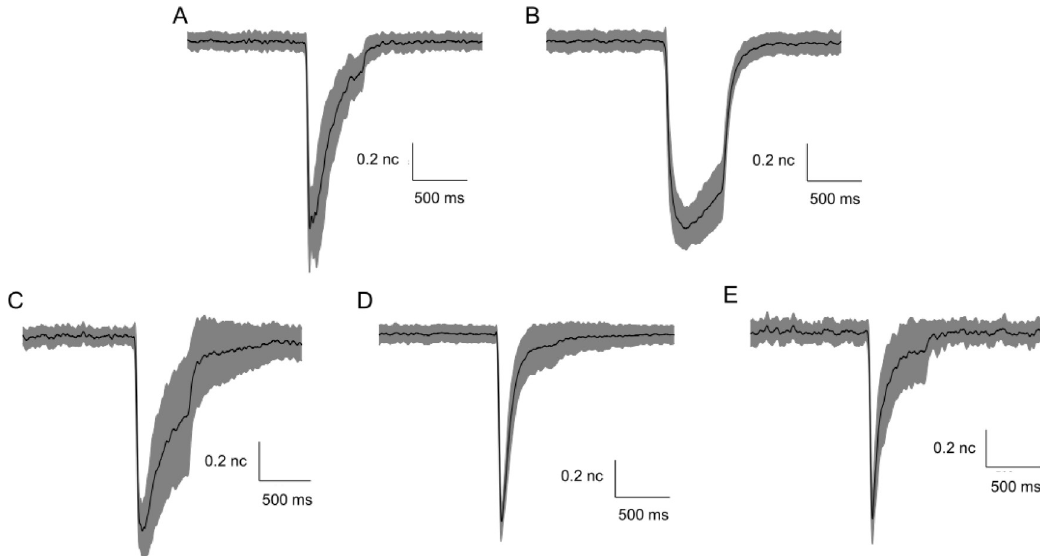
Fig 6. Normalized mean whole-cell currents from cotransfected E2117A and E2117D. Panels on top show normalized mean currents from cells transfected with either E2117A (A) or E2117D (B) . The panels on the bottom show normalized mean currents from cotransfection of E2117A and E2117D in different ratios: E2117A:E2117D::1:2 ( Panel C ), E2117A:E2117D::1:1 (D) and E2117A:E2117D::2:1 (E) . The mean current is the central black trace and the standard deviation in the data is the filled gray areas. Since these currents are normalized, the scale representing these values is labeled “nc” for normalized current. The inactivation profiles of the mean currents in these cotransfections seem to follow the profile of whichever channel is expected to be expressed more densely. Hence, E2117A:E2117D::1:2 appears more like E2117D and E2117A:E2117D::2:1 appears more like E2117A.